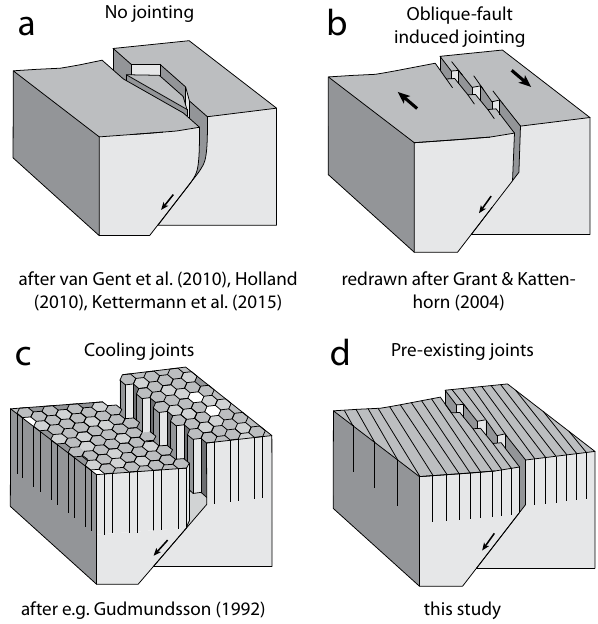
Figure 17. Conceptual models illustrating different fault shapes ac- cording to the influence of preexisting joints. With no preexisting joints (a) faults show an irregular lateral fault shape resulting from fault segments growing together (after van Gent et al., 2010; Ket- termann and Urai, 2015). (b) Joints forming due to oblique faulting are slightly inclined to the fault and limited in length. However, the fault shape can be very similar to the shown examples formed by preexisting joints (after Grant and Kattenhorn, 2004). (c) Fault lo- calization at preexisting cooling joints in columnar basalts resemble the same process; however the fault shape is affected differently by the different joint pattern (after Gudmundsson, 1992). (d) A regular preexisting joint pattern as shown in this study strongly controls the fault shape but can look similar to case (b)